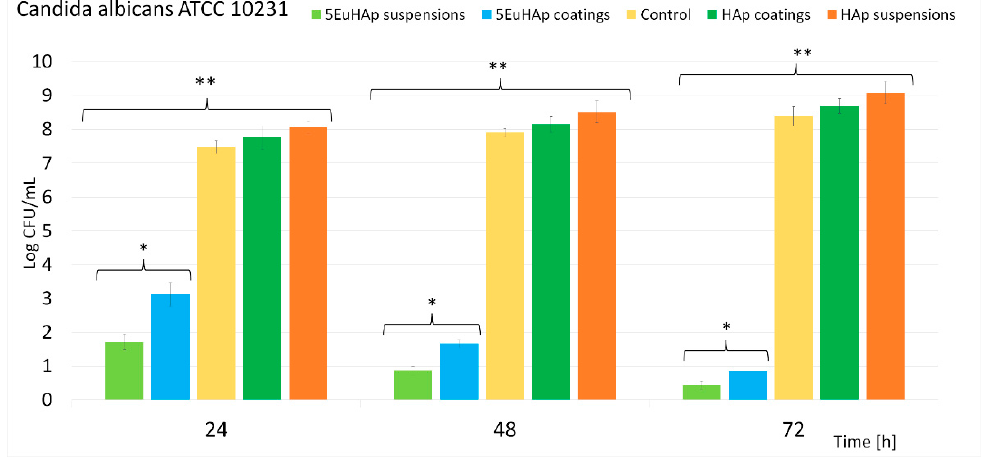
Figure 11. Antifungal activity of HAp and 5EuHAp suspensions and coatings on the development Candida albicans ATCC 10231 fungal cells over different incubation periods. The results are presented as mean ± SD. Statistical analysis was performed by one-way ANOVA. The determined p -values: * p ≤ 0.002, ** p ≤